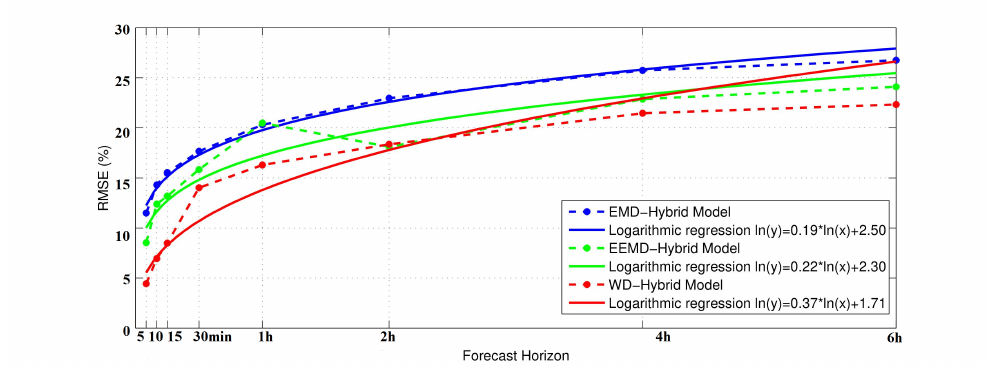
Figure 8. Strategy 2 rRMSE error (dotted line) and their logarithmic regression (solid line), in the logarithmic regression equation, y refers to the RMSE and x refers to the forecast horizon τ .